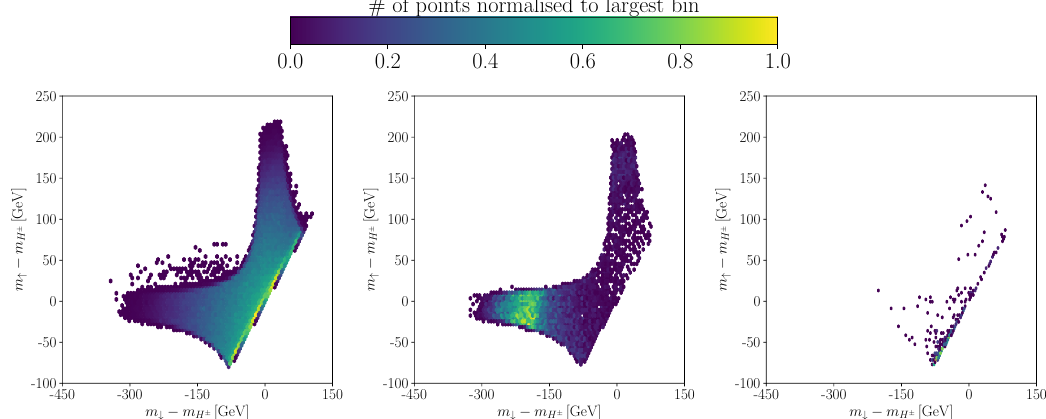
Figure 14 . Type II, H 1 = h : the mass di(cid:11)erence m " (cid:0) m H (cid:6) versus m # (cid:0) m H (cid:6) . The colour code shows the relative frequency of left: all points passing the constraints; middle: all points with a strong PT and CP conservation; right: all points with (cid:24) c 1 and explicit CP violation. (cid:21) that can be searched for at the LHC. In contrast the right plot shows that the